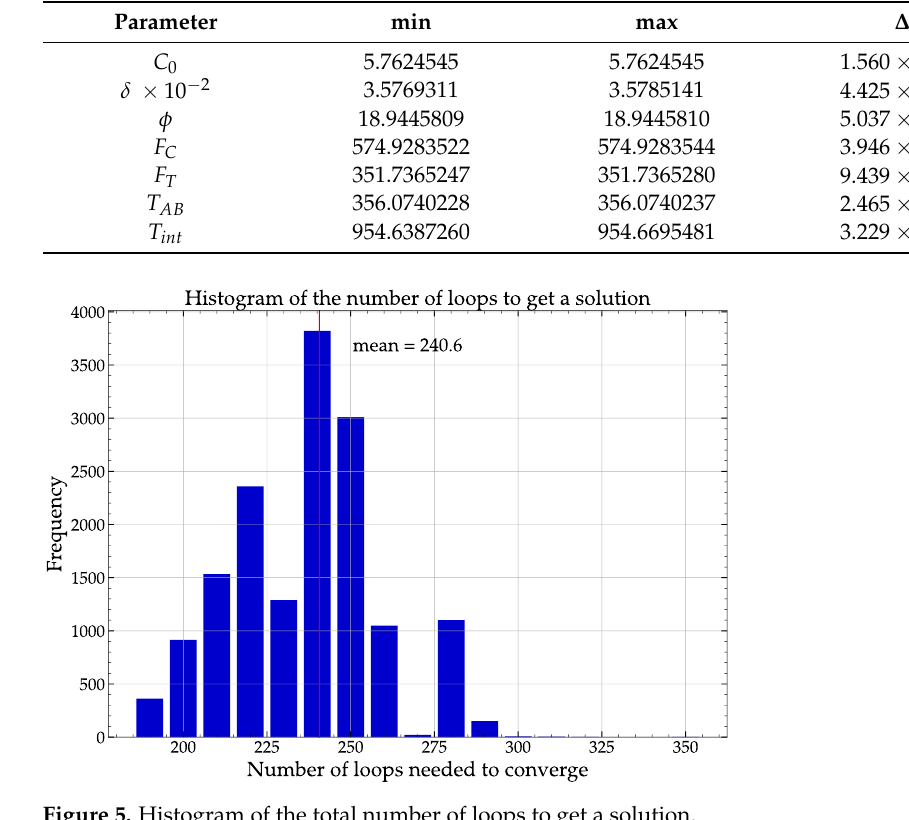
Table 3. Model results for the 15,625 computations.